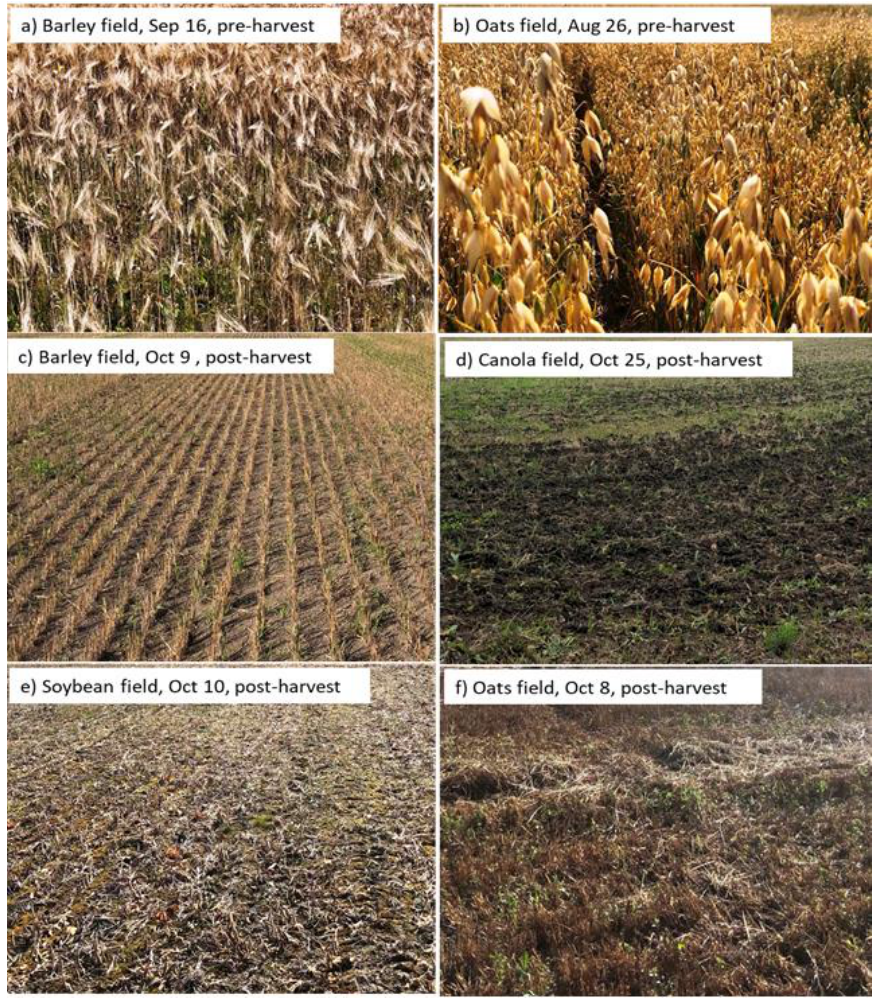
Figure 7. Pre-harvest ( a–b ) and post-harvest ( c–f ) photos for the four example fields shown in